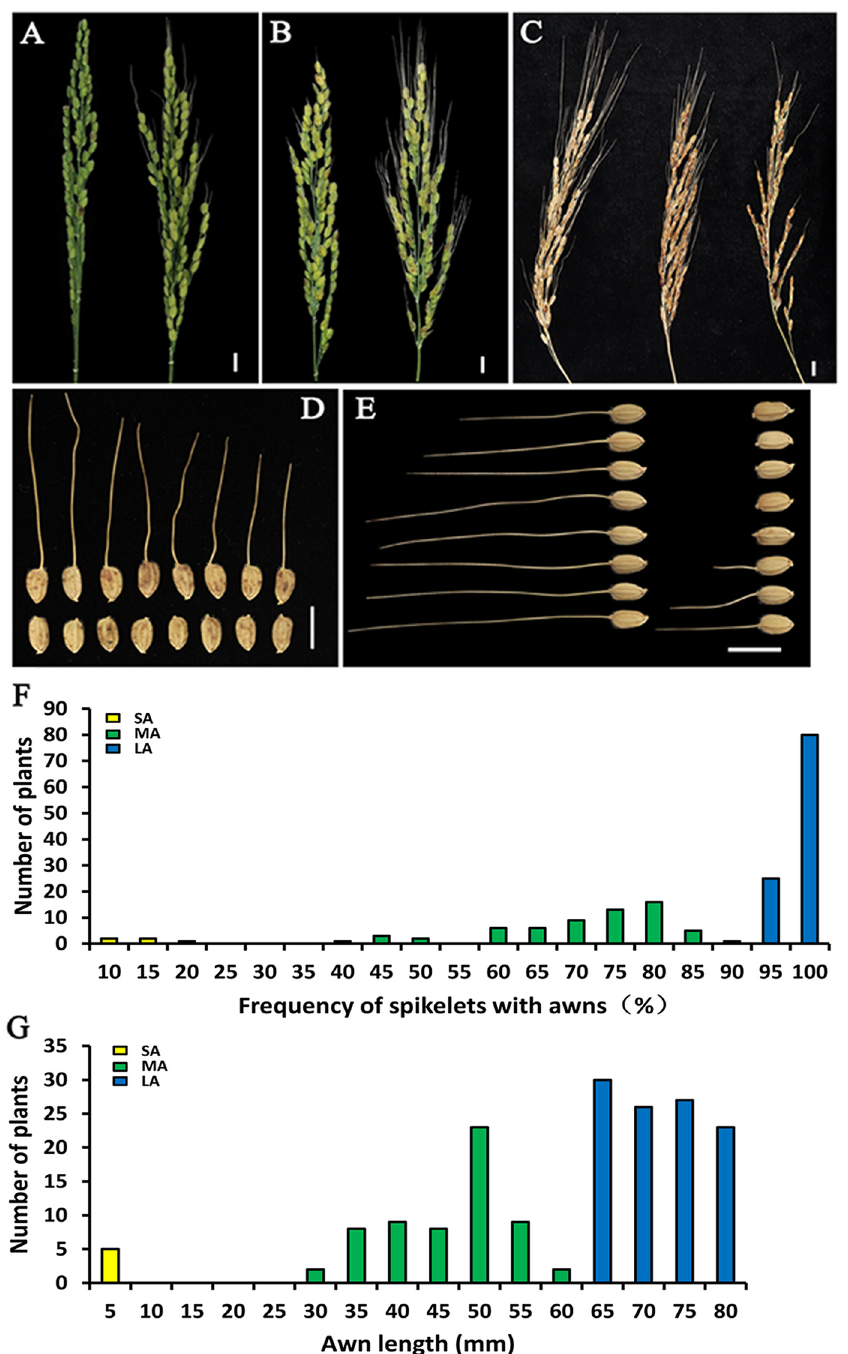
Fig 1. Awn phenotypes. (A) Panicle phenotypes comparing BM33a (right) and BM33b (left); (B) BM38a (right) and BM38b (left). (C) Distinguishable phenotypes in the F 2 population of the cross between NILs BM33a and BM38a. These classes were consistent with the presence of LA (left), MA (center) and SA (right). Phenotypic comparison of seed arrays from mature spikelets of NIL lines BM33a (upper) and BM33b (lower) (D) and BM38a (left) and BM38b (right) (E). (F) Distribution of awn ratio. (G) Distribution of awn length. Bars, 10 mm. See Table 2 for abbreviations LA, MA, and SA.